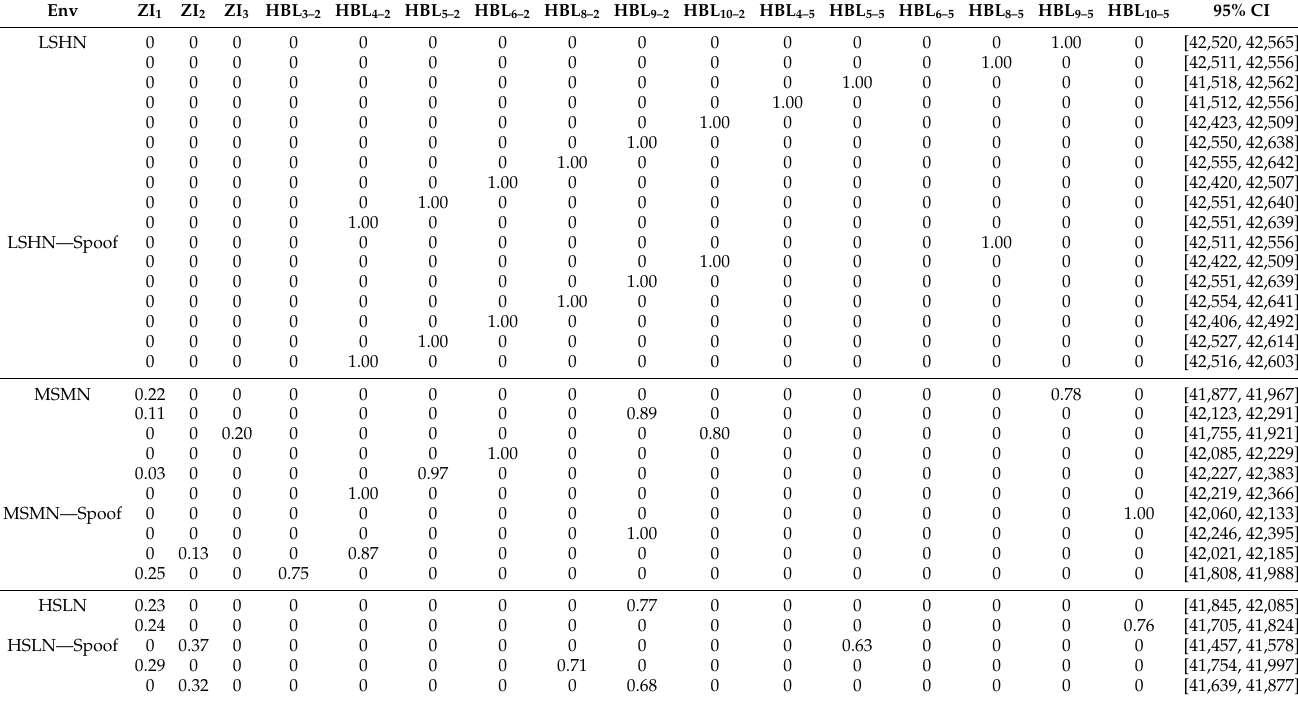
Table A20. Equilibria for games where the learning-based trading strategy set is comprised of standard HBL, HBL with price level blocking, HBL with price offsets and HBL with both price offsets and price level blocking (HBL 1 and HBL 2 are not shown because they do not appear in any equilibrium). Each row describes an equilibrium found for the game described by the Env column, detailing the adoption rate of each strategy considered and the corresponding background surplus.